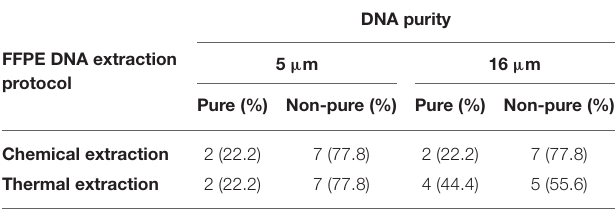
TABLE 1B | Comparison of chemical and thermal DNA extraction protocols in six FFPE pellet samples of Sporothrix sp. and negative controls, using the two paraffin sectioning protocols, in relation to the degree of DNA purity (A 260 /A 280 nm ratio).